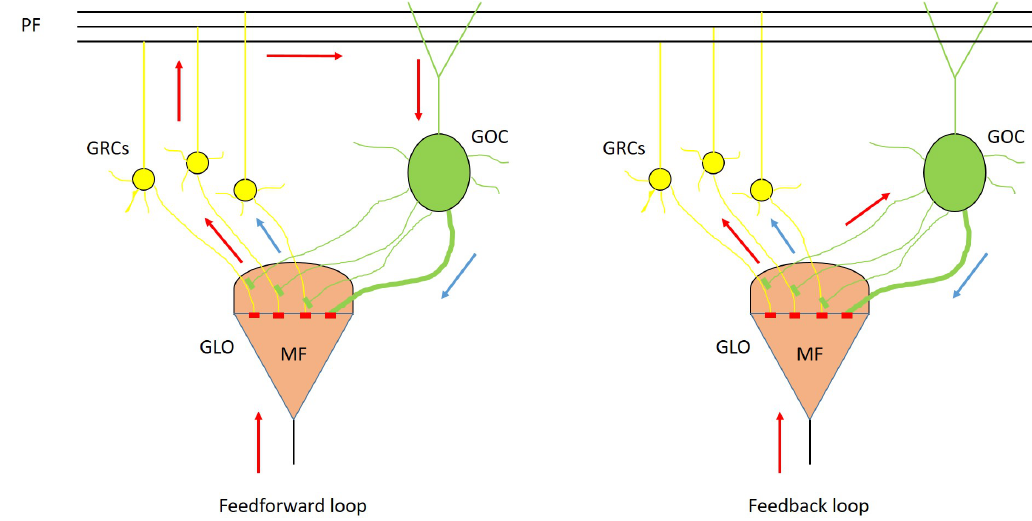
Figure 1. Feedforward and feedback loops. In the first loop, the MF excites the GRCs (yellow spheres), then the signals travel along the parallel fibers and excite the GOC (green sphere) that inhibits the GRCs. In the second loop, the MF excites the GRCs and the GOC, which later inhibits the GRCs. For both the loops, the excitatory signals are shown with red arrows, while the inhibitory ones are represented with blue